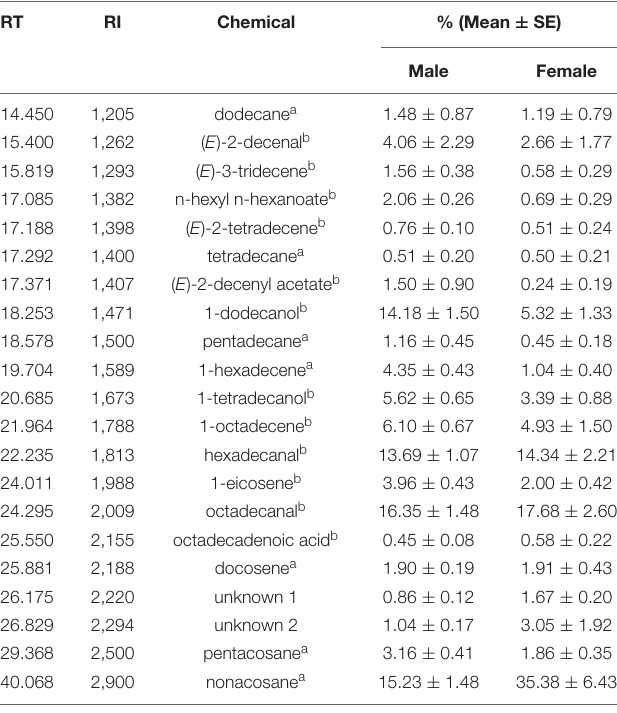
TABLE 1 | Compounds detected in hexane extracts of dissected body parts from Halyomorpha halys adults.